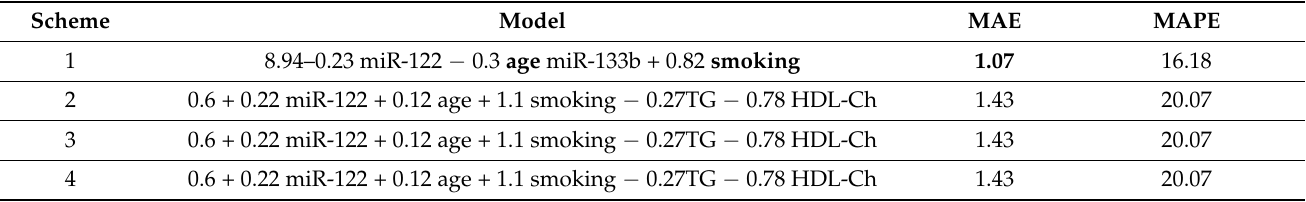
Table 5. Factors predicting CAVI.